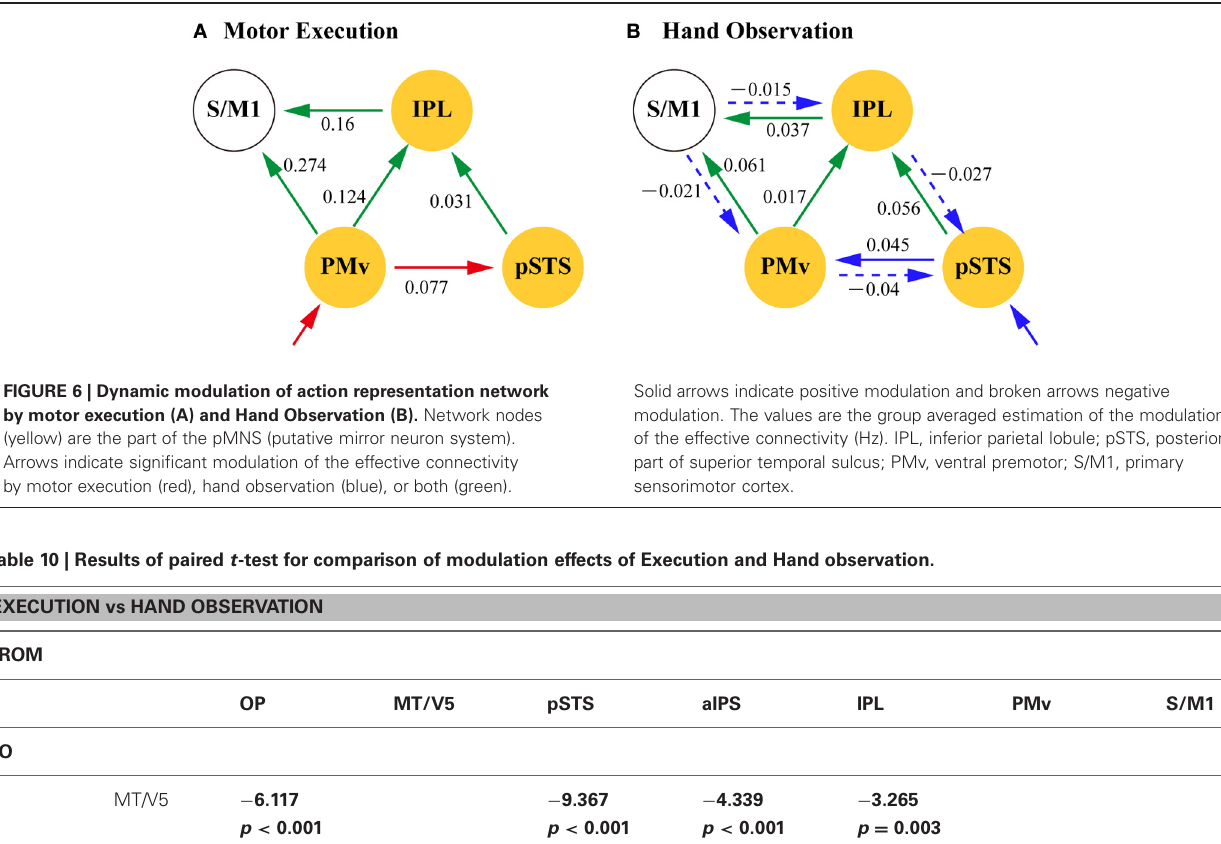
Table 10 | Results of paired t -test for comparison of modulation effects of Execution and Hand observation. EXECUTION vs HAND